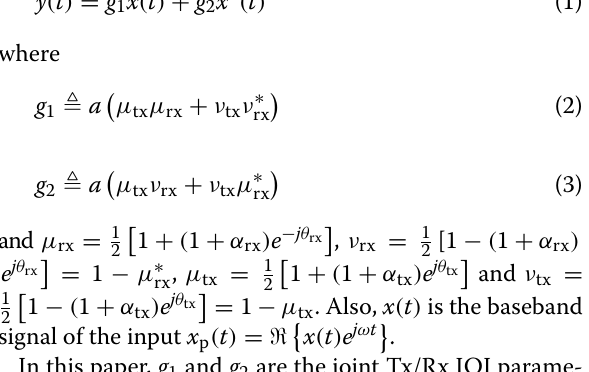
the signal is affected by the Rx/Tx gain imbalance α rx /α tx and the Rx/Tx phase-shift imbalance θ rx /θ tx . Since the frequency-dependent IQI plays a minor role compared to the dominant effect caused by the frequency-independent IQI [23], the former is not considered in this model. After the imperfect RF front-end, the passband signal y p ( t ) = (cid:2) (cid:3) (cid:3) y ( t ) e j ω t is forwarded to the destination, where y ( t ) denotes the baseband equivalent signal as